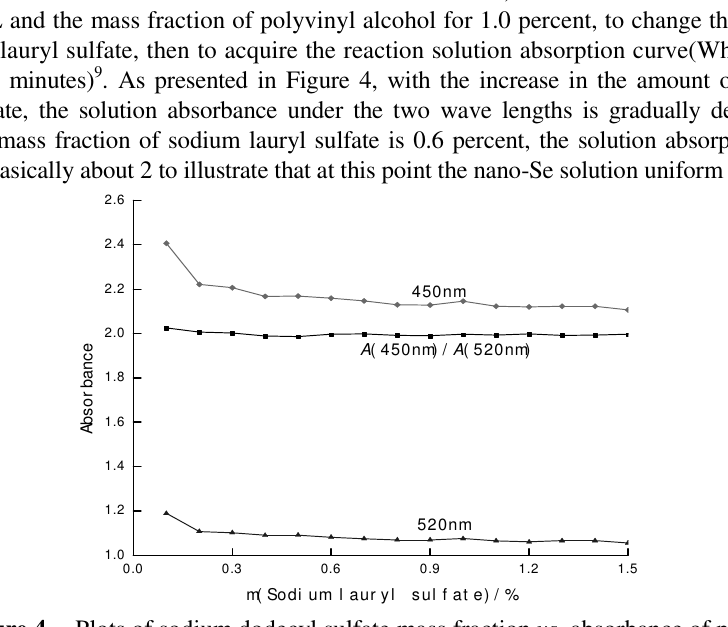
Figure 4. Plots of sodium dodecyl sulfate mass fraction vs. absorbance of